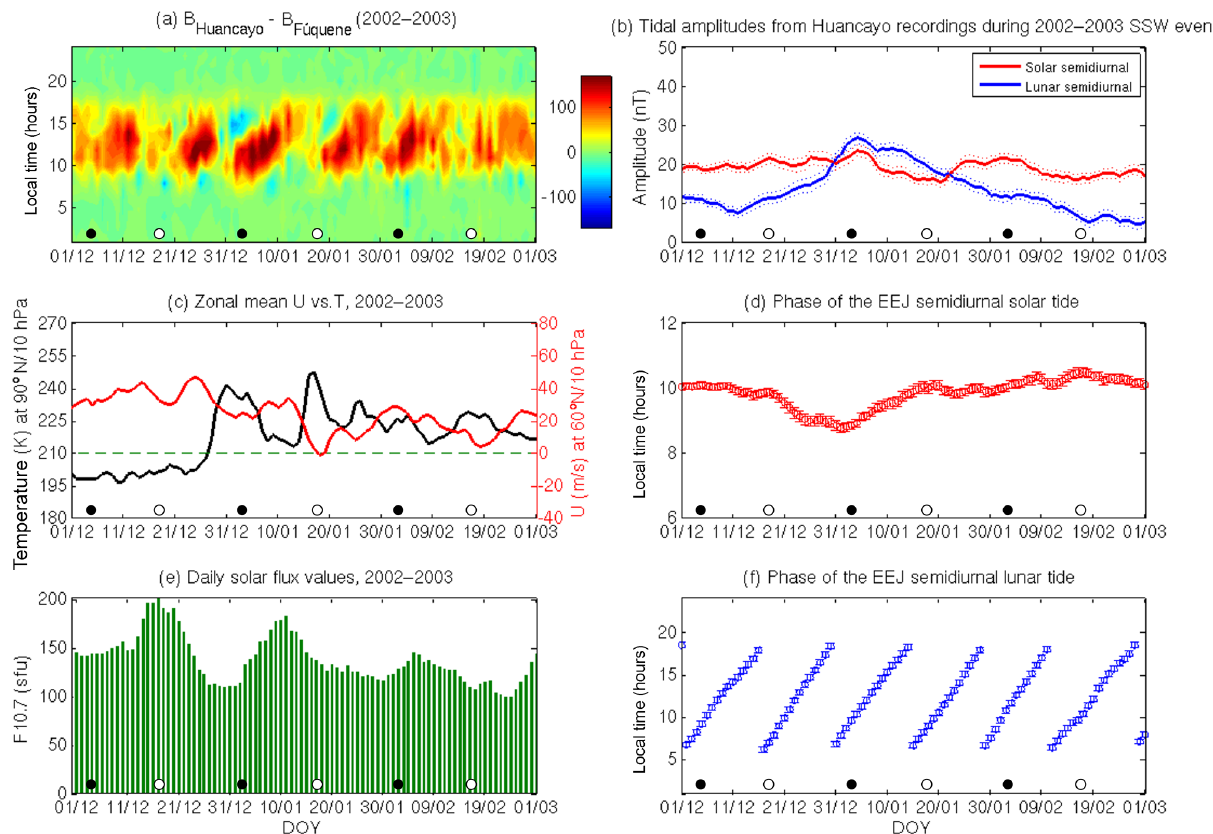
Figure 2. (a) the day-to-day variations of the EEJ obtained from Huancayo and Fúquene observatories between 1 December 2002 and 1 March 2003 are presented in this plot. The white and black dots at the bottom represent the days of full moon and new moon, respectively. (b) the amplitude of the semidiurnal solar (red) and lunar (blue) tides of the EEJ during the same period. The dotted lines represent the 1 σ uncertainty levels. (c) daily time series of the zonal mean zonal wind ( U ) at 60 ◦ N and 10hPa (red), and the North Pole temperature at 10hPa (black) during the same period. The dashed green line is marked to identify the day of reversal of the zonal mean zonal wind. (d) the phase of the semidiurnal tide of the EEJ. (e) daily solar flux values during this time interval. (f) the phase of the semidiurnal lunar tide of the